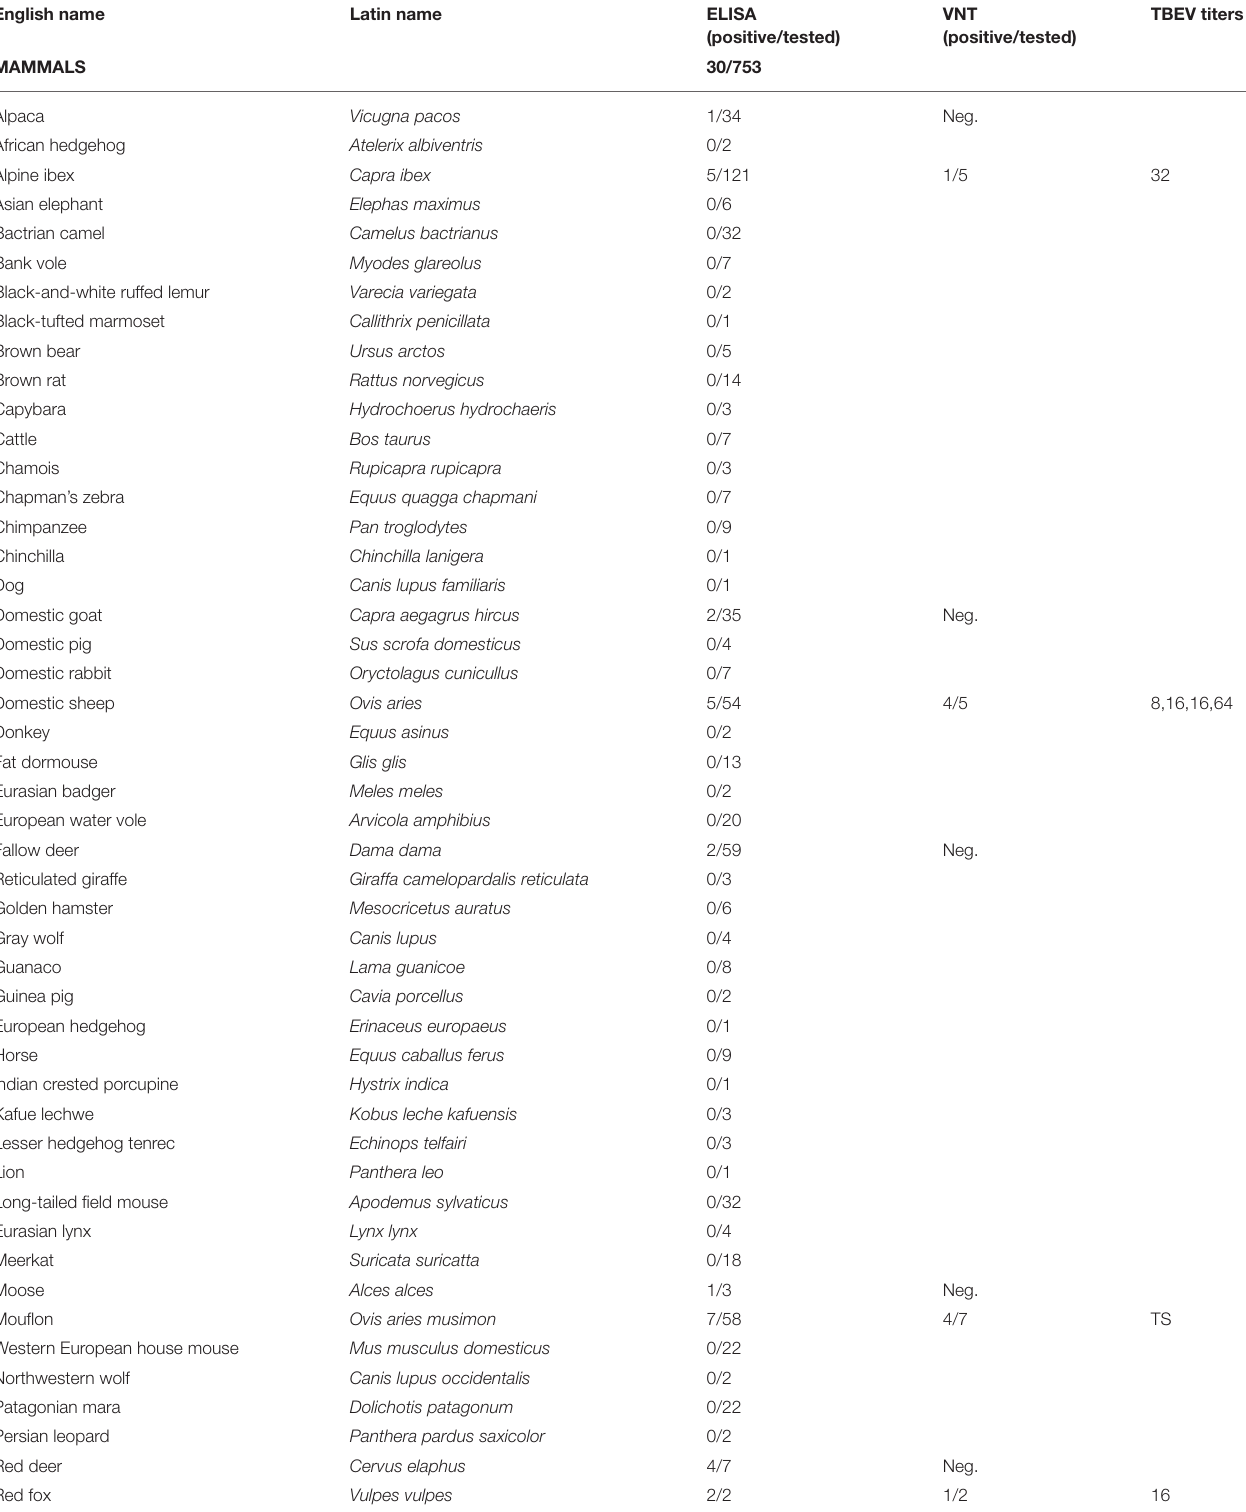
TABLE 1 | Results of serological examination of zoo animals for antibodies to tick-borne encephalitis virus (TBEV) tested by enzyme-linked immunosorbent assays (ELISA) with confirmation of positive samples by virus neutralization test